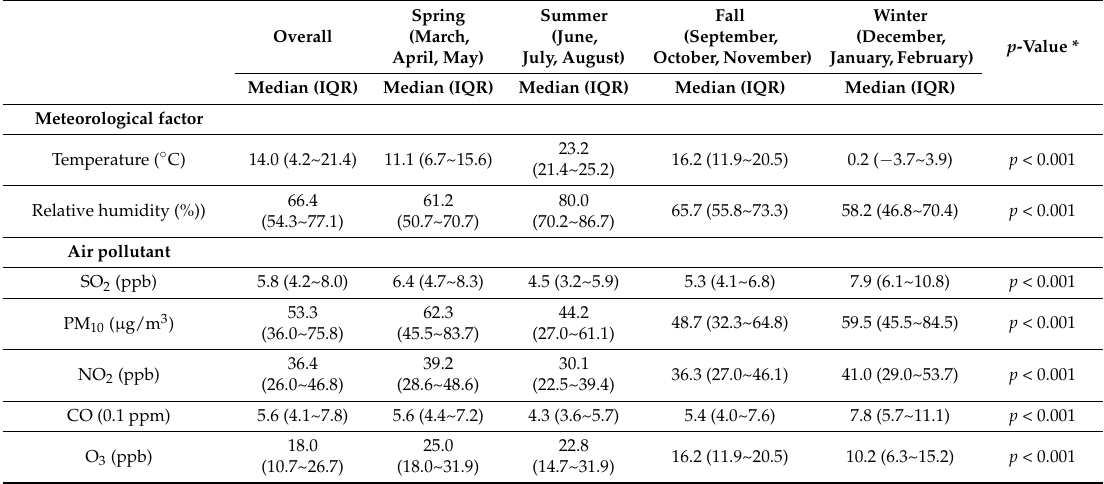
Descriptive summary of baseline meteorological factors and air pollutants in neversmoking